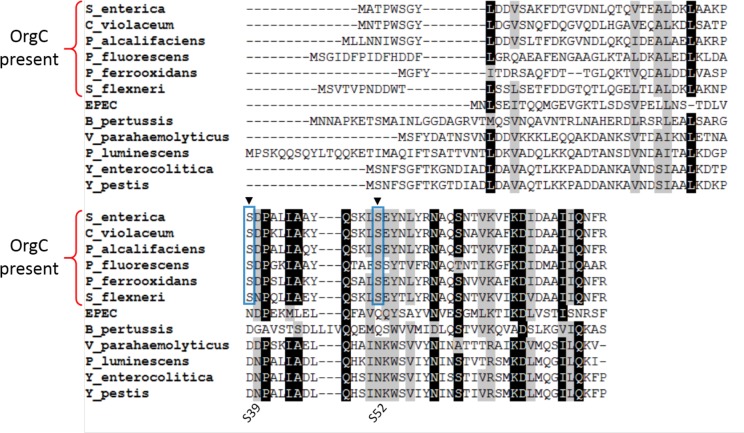
PrgI residues (Ser39 and Ser52) directly involved in OrgC binding are exclusively conserved in PrgI homologs that have an OrgC partner.Multiple sequence alignment of different needle proteins from several bacteria carrying T3SSs. Ser39 and Ser52 are marked with filled black arrowheads. NCBI accession numbers for the needle proteins: Salmonella enterica (PrgI, CBW18951), Chromobacterium violaceum (OQS28935), Providencia alcalifaciens (EUC99172), Pseudomonas fluorescens (MxiH, AKV07676), Pseudogulbenkiania ferrooxidans (ERD99717), enteropathogenic Escherichia coli (EscF, CAS11480), Bordetella pertussis (BscF, CAC79556), Vibrio parahaemolyticus (PscF, KIT21774), Photorhabdus luminescens (LscF, AAO18031), Yersinia enterocolitica (YscF, AAD16839), Yersinia pestis (YscF, NP_395189). The alignment was carried out using Muscle and prepared for visualization using BioEdit. Residues identical are indicated in a black background whereas similar residues are marked gray if they are present in ≥80% of the sequences.